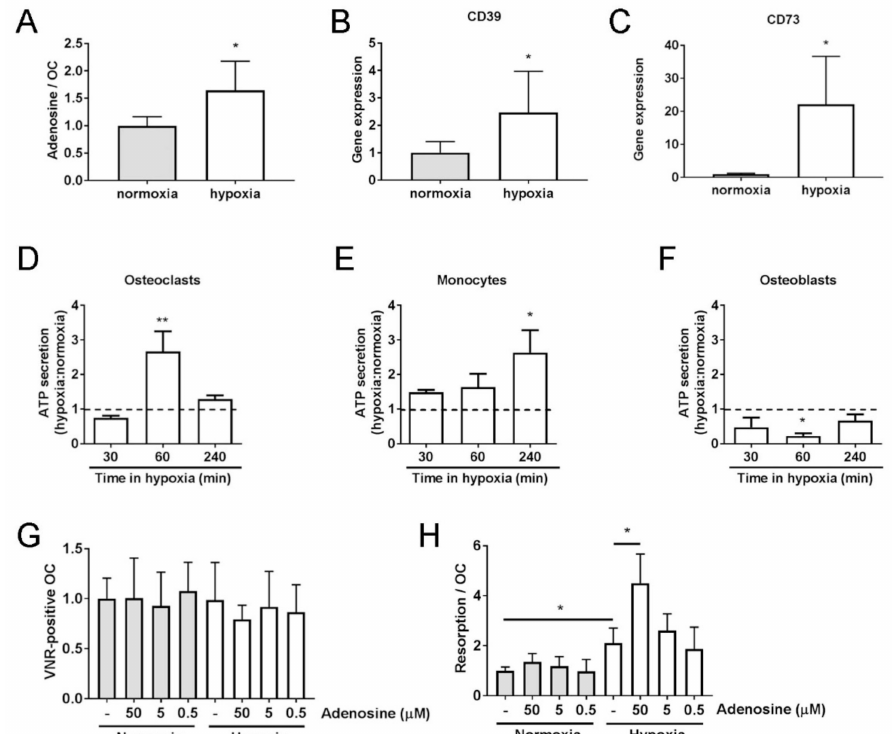
Figure 3. Hypoxic osteoclasts secrete ATP to increase adenosine concentrations. ( A ) A 24 h exposure of mature human osteoclasts to hypoxia (2% O 2 , white bars) increases the concentration of extracellular adenosine ( n = 4) and ( B ) increases the expression of ectonucleotidase CD39 and ( C ) ectonucleotidase CD73 mRNAs. ( n = 5). ( D – F ) E ff ect of 30–240 min hypoxia on ATP secretion by ( D ) mature human osteoclasts, ( E ) CD14 + monocytes and ( F ) primary human osteoblasts ( n = 4). ( G ) Quantified e ff ect of 24 h exposure of mature human osteoclasts to adenosine (0.5–50 µ M) with respect to osteoclast